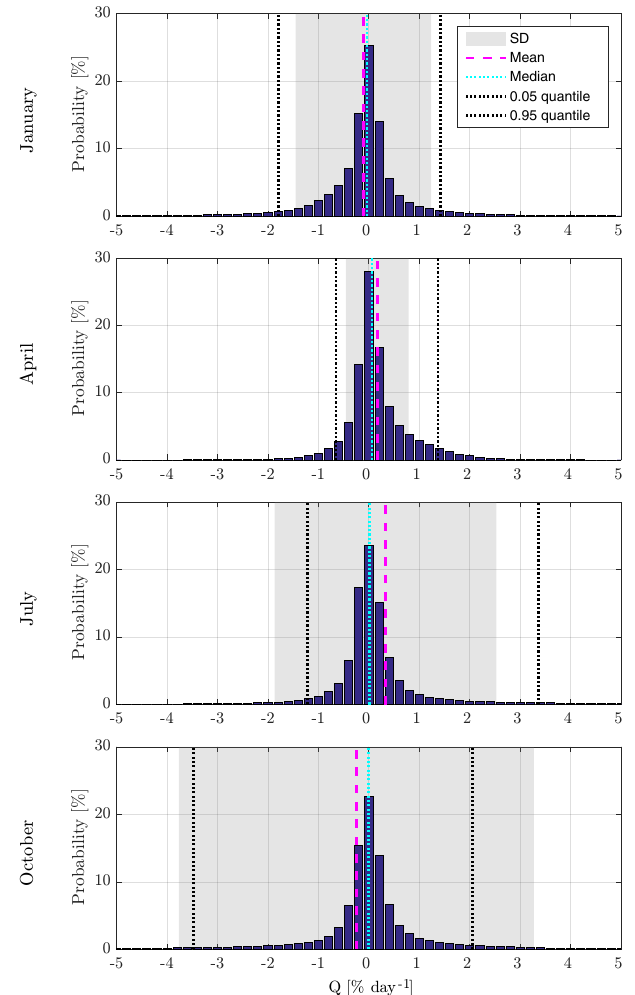
Figure 4. Probability distribution of error quantity Q of monthly testing data sets January, April, July and October. Grey shading in- dicates the standard deviation around the mean (pink dashed line). The dotted lines shows the median (cyan) and 5 and 95% quantiles